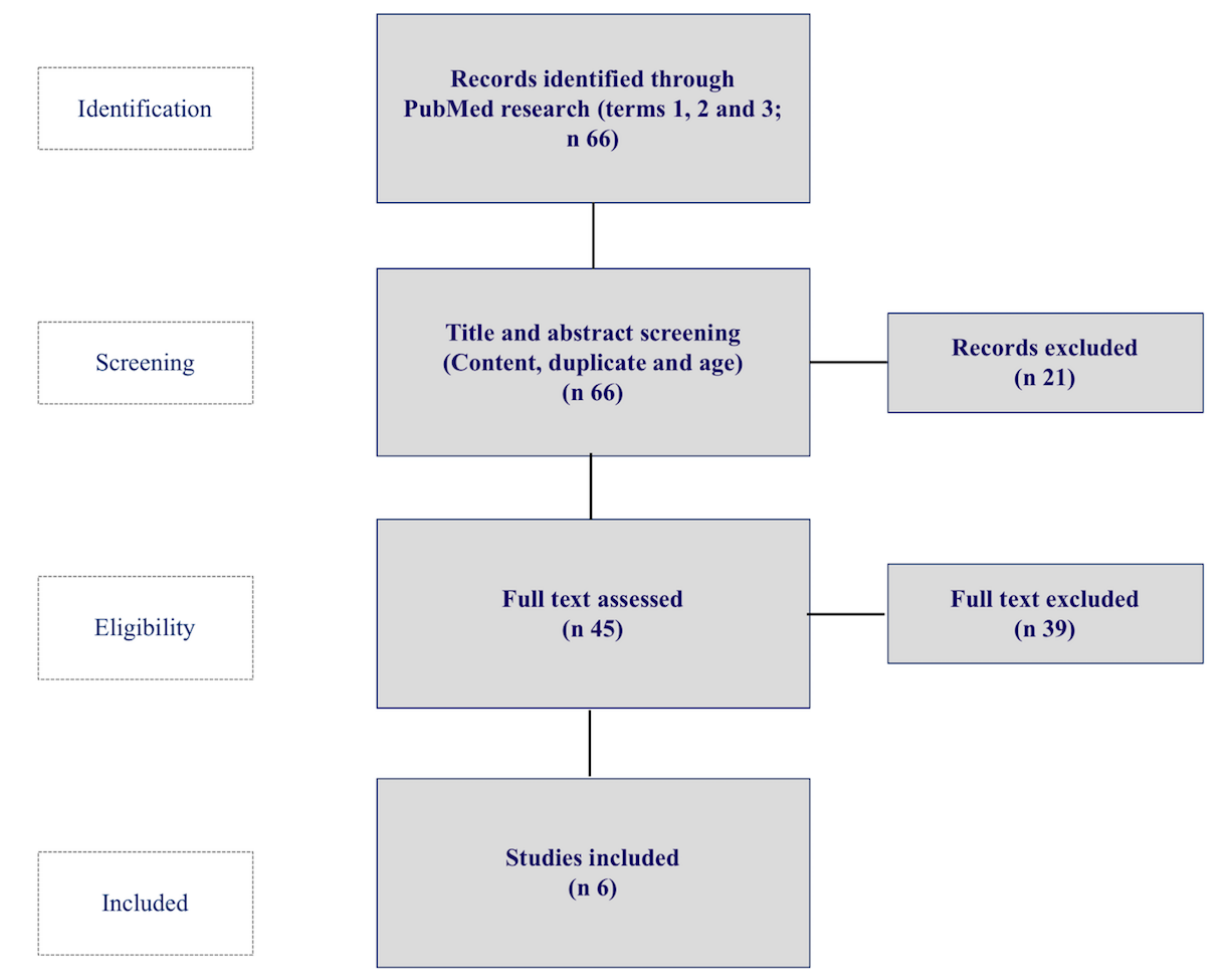
Figure 1. Study selection and identification